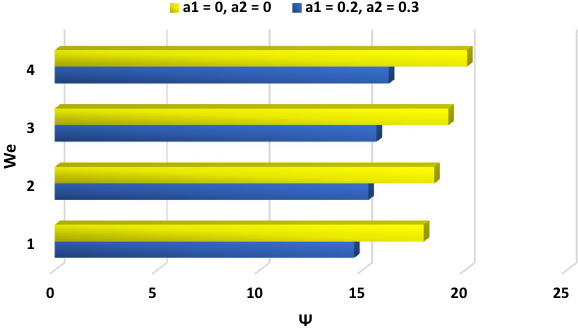
Figure 11. Impact of We on ψ in the presence of an amplification in a 1 .